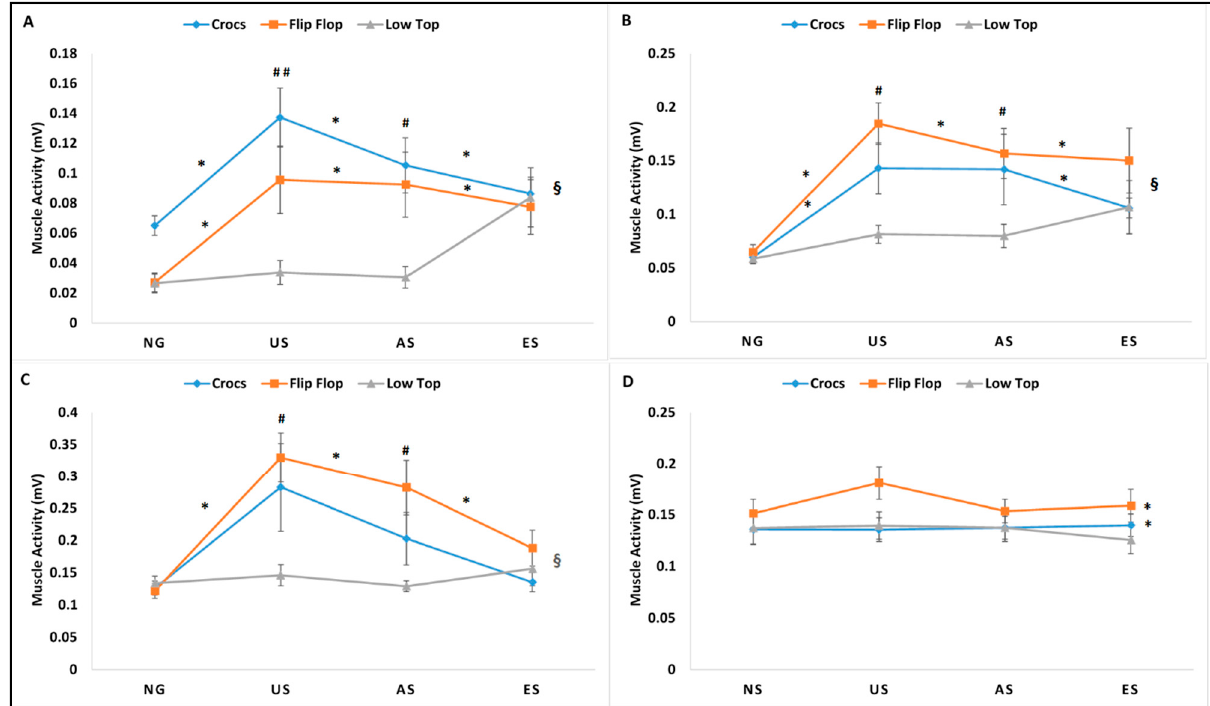
Figure 4. Mean muscle activity (mV) for vastus medialis ( A ), medial hamstrings ( B ), tibialis anterior ( C ), and medial gastrocnemius ( D ) during stance phase for Crocs, flip-flops, and low top slip resistant shoe during normal gait (NG), unexpected slip (US), alert slip (AS), and expected slip (ES) events. § denotes significant interactions between footwear type and gait/slip trial; * denotes significant difference for footwear across gait trials, and # denotes significant difference for gait trials across footwear. All differences were significant at the alpha level p < 0.05.